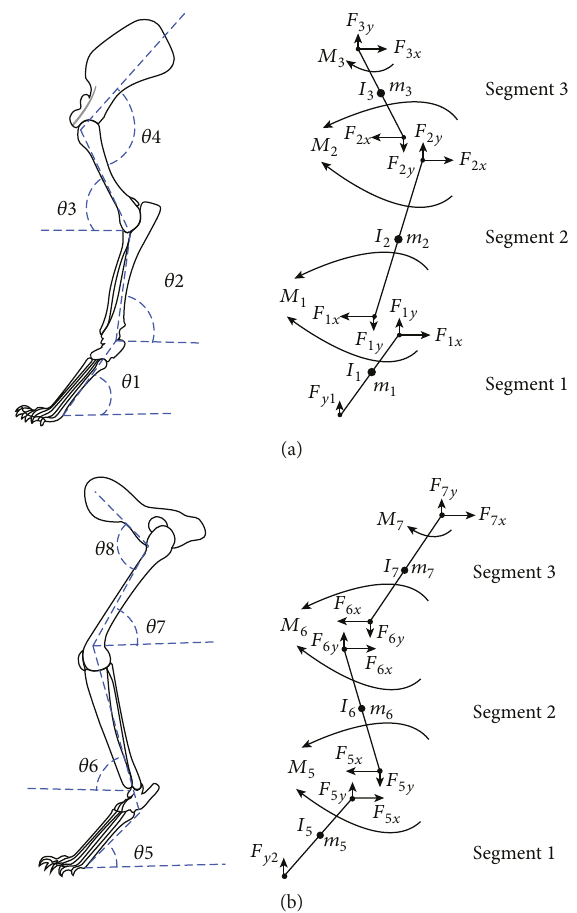
Figure 1: The left side shows the angles of the forelimb (a) and hindlimb (b) used in the equations, and the right side shows free- body diagrams of the same limbs, in which the reaction forces and moments acting on each joint are